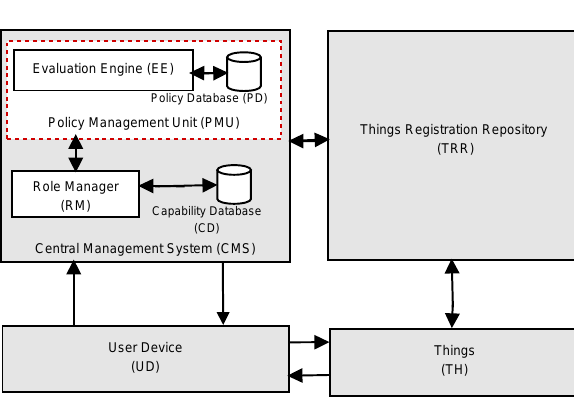
Figure 6. The proposedaccess